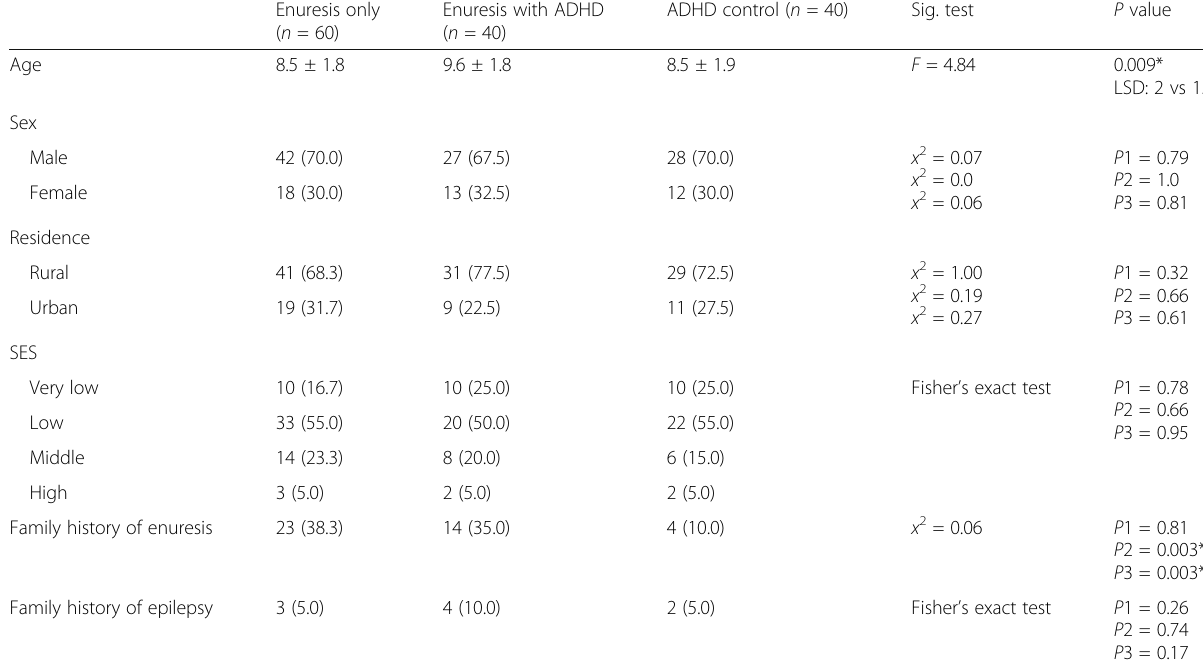
Table 1 Socio-demographic characteristics of the 3 studied groups